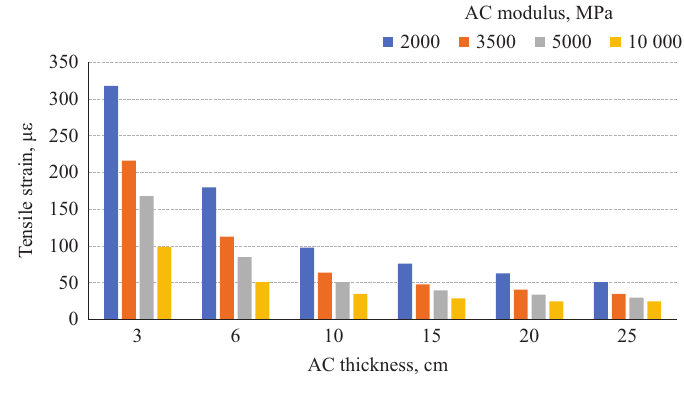
Figure 6. Longitudinal tensile strain at the bottom of the asphalt concrete versus overlay